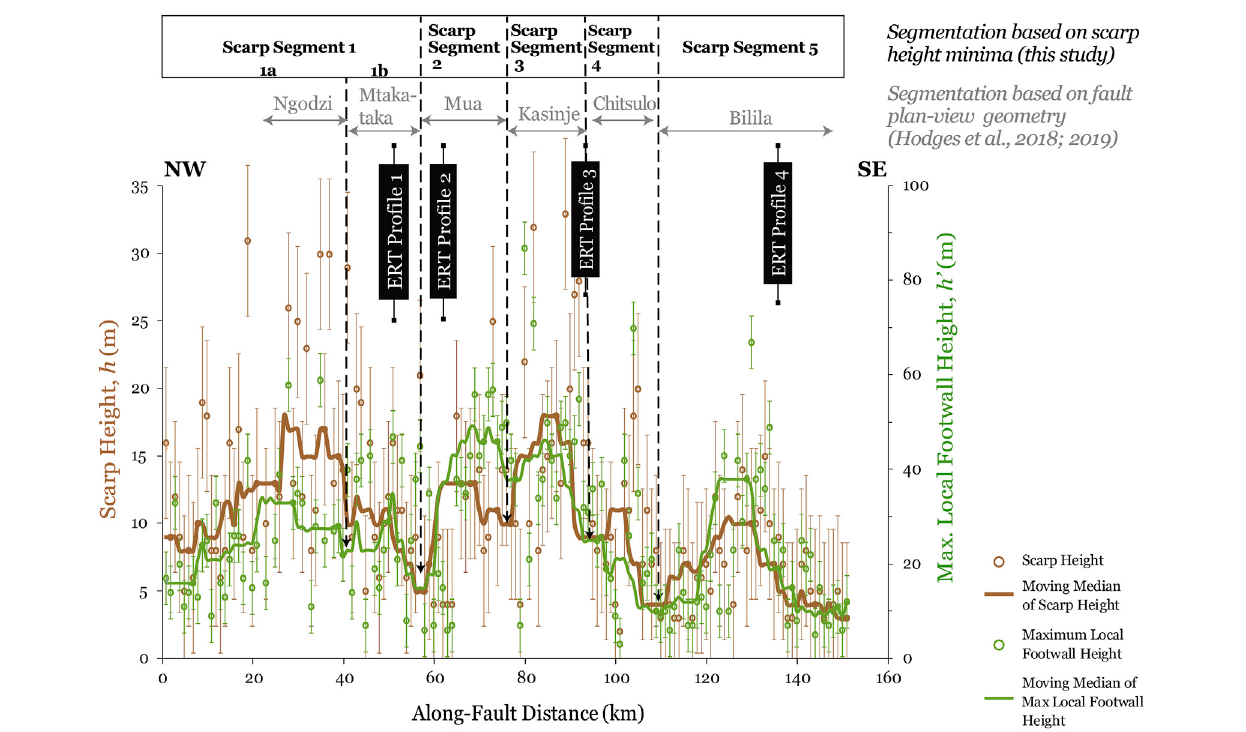
FIGURE 4 | Distribution of scarp height ( h ) and maximum local footwall elevation ( h ’ ) versus distance along-strike of the BMF. The “ scarp segments ” indicate the fault segmentation based on the scarp height minima along the moving median curve. Segmentation based on plan-view fault geometry is from Hodge et al. (2018). Dashedverticallinesshowthelocationofthelocationsofthemovingmedianminimawhichisconsistentwiththetransitionfromonegeometricalsegmenttoanother.The error bars show5.6 mabsoluteerror associated withSRTM-DEM inthevertical directions.Note thattheverticalscales aredifferentfor scarpheight and maximum footwall height